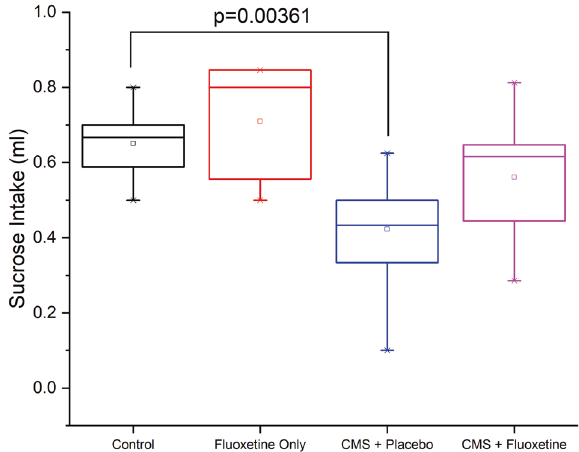
Fig. 1 Evaluation of the antidepressant effects of an antidepres- sant by the sucrose intake test in rats. Rats received sucrose solution volume (ml) control, fl uoxetine only, CMS + placebo and CMS + fl uoxetine